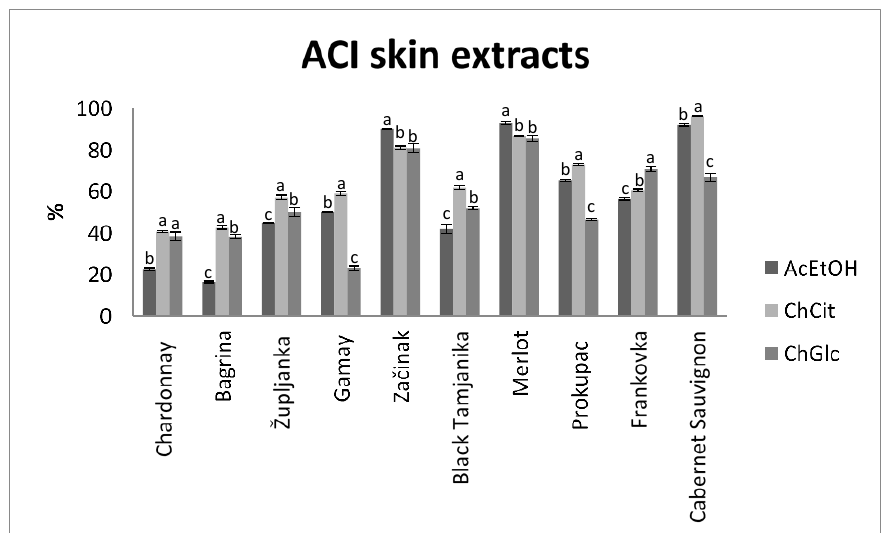
Figure 4. Antioxidant composite index- grape skin extracts. Data are expressed as % for each variety, means ± SD, n = 3. Di ff erent lower case letters (a–c) indicate significant di ff erences among solvents ( p ≤ 0.05) based on post hoc Tukey’s test. Abbreviations: ACI—Antioxidant Composite